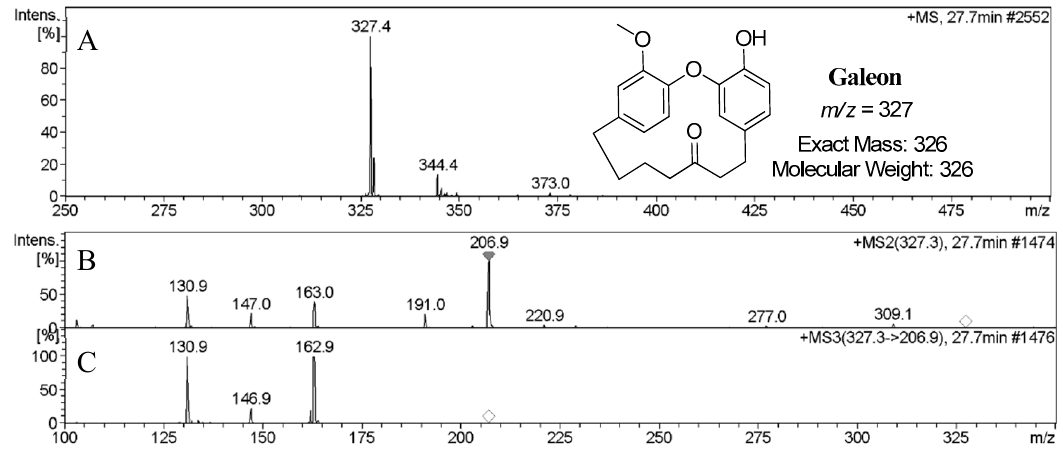
Figure 4. Mass spectra of galeon: ( A ) MS spectrum; ( B ) MS 2 spectrum; ( C ) MS 3 spectrum.